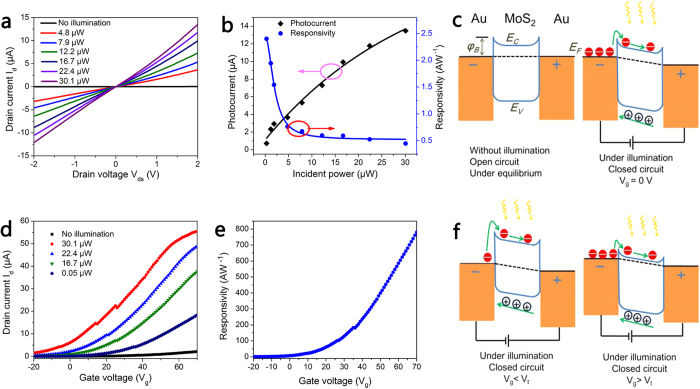
Optoelectronic characterisations of a multilayer MoS2 phototransistor.(a) Device drain current (Id) as a function of source-drain voltage (Vds) for an excitation wavelength of 405 nm with different incident powers. (b) The dependence of photocurrent and photoresponsivity on incident power. The blue and black dots are the original data, whereas the lines are the exponential curves. (c) Schematic energy diagram of the device without and with illumination showing the energy barrier and photocurrent generation process. There is a non-zero source-drain bias (Vds ≠ 0 V), but the gate bias is kept at zero (Vg = 0 V). (d) Device drain current as a function of gate voltage under different illumination powers. Source-drain bias: Vds = 1 V. (e) The photoresponsivity versus back gate voltage. Source-drain bias: Vds = 1 V; light power: 50 nW. (f) Schematic energy diagram showing photocurrent generation processes with different gate bias (Vg < Vt and Vg > Vt). There is a non-zero source-drain bias.